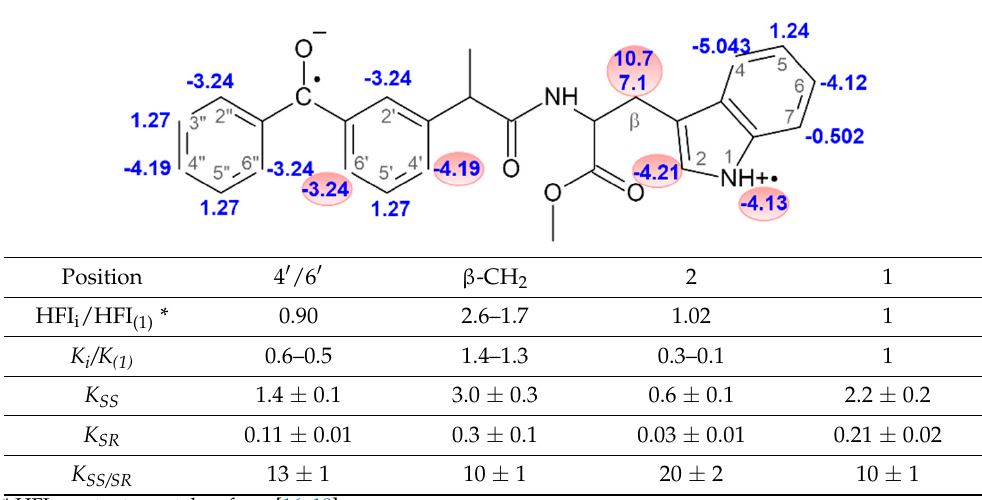
Table 5. Spin selectivity of protons in diastereomers of dyad IV detected in solvent with different dielectric constants (CD 3 CN/C 6 D 6